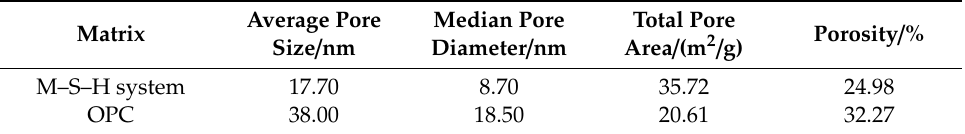
Figure 13. Pore size distribution ( a ) and accumulative pore area ( b ) of the M–S–H system-solidified body and ordinary Portland cement (OPC)-solidified body. Table 7. Pore structure analysis of M–S–H system-solidified body and OPC solidified body.